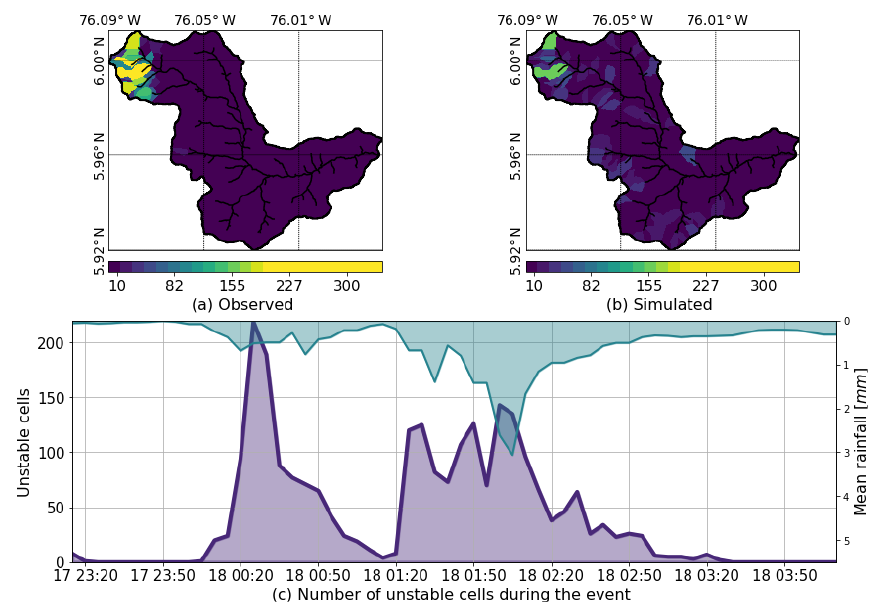
Figure 15. (a) Observed landslides triggered by Events 1 and 2. The figure is based on aerial photos and satellite images taken before and after the flash flood event. (b) Map of total unstable cells during the simulation period. (c) Time series of the number of simulated unstable cells during Event 2 (continuous purple line) and mean rainfall over the basin (inverse axes, blue